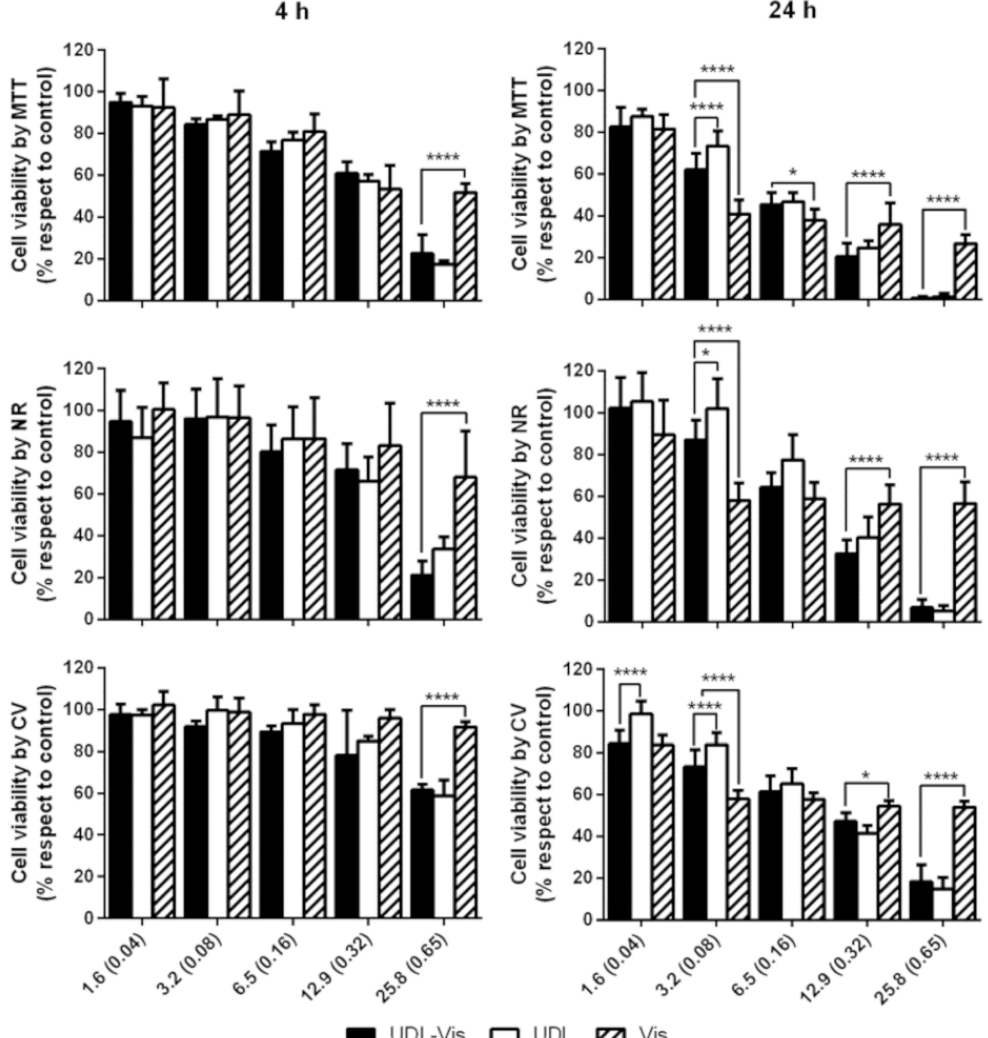
Figure 5. Percentage of cell viability of HaCaT after ( 4 h ) and ( 24 h ) of incubation with UDL, UDL-Vis, and free Vismodegib (Vis) as determined by MTT, neutral red (NR), and crystal violet (CV). Concentrations are expressed as the concentration of SPC in mM and within the parenthesis the concentration of Vismodegib in mg/mL. Data are presented as mean ± SD ( n = 3). Statistical analysis is only shown in those concentrations in which the changes were significant with respect to the control (determined by one-way ANOVA analysis). * p < 0.05, **** p <